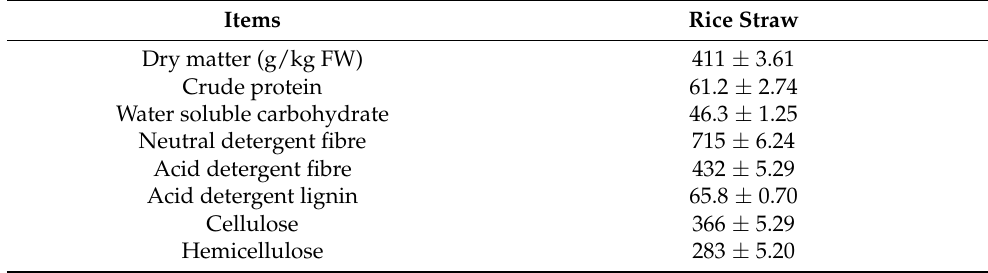
Table 1. Chemical composition of raw rice straw (g/kg DM or as stated).